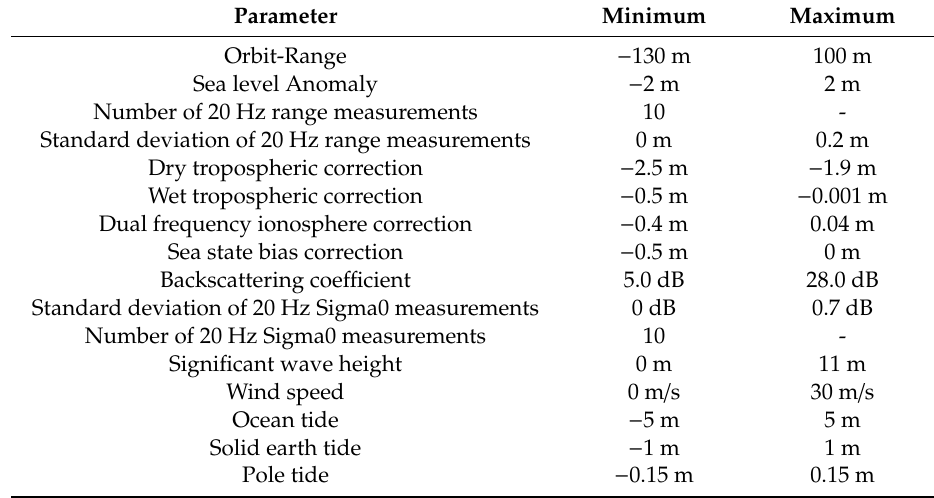
Table 2. Thresholds used for the main altimeter and radiometer parameters in the Sentinel-3A SRAL data editing